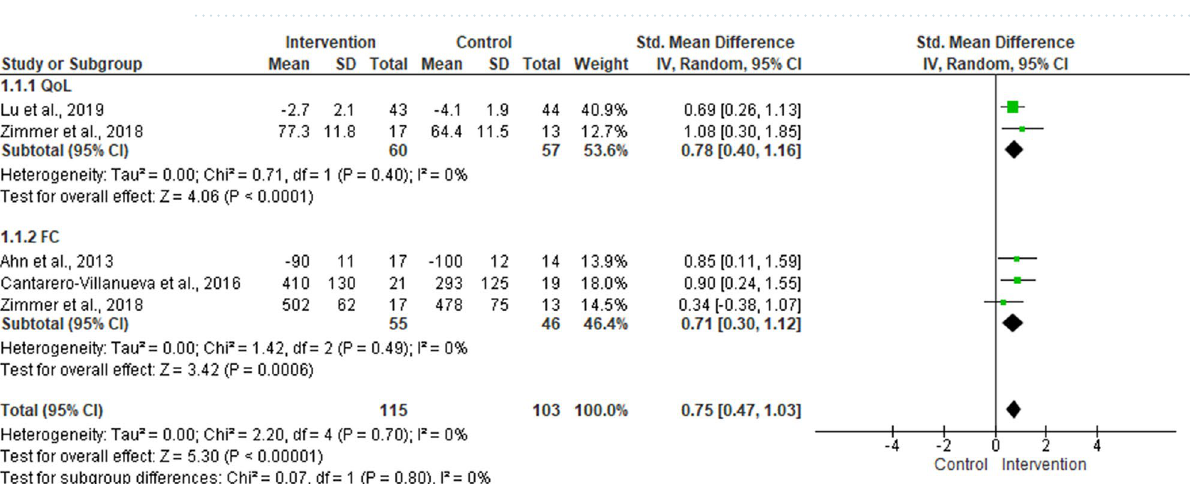
Figure 4. Meta-analysis of quality of life (QoL) and functional capacity (FC) measured in randomized controlled trials that conducted exercise intervention entirely supervised or with some level of supervision (mixed) for colorectal cancer patients.